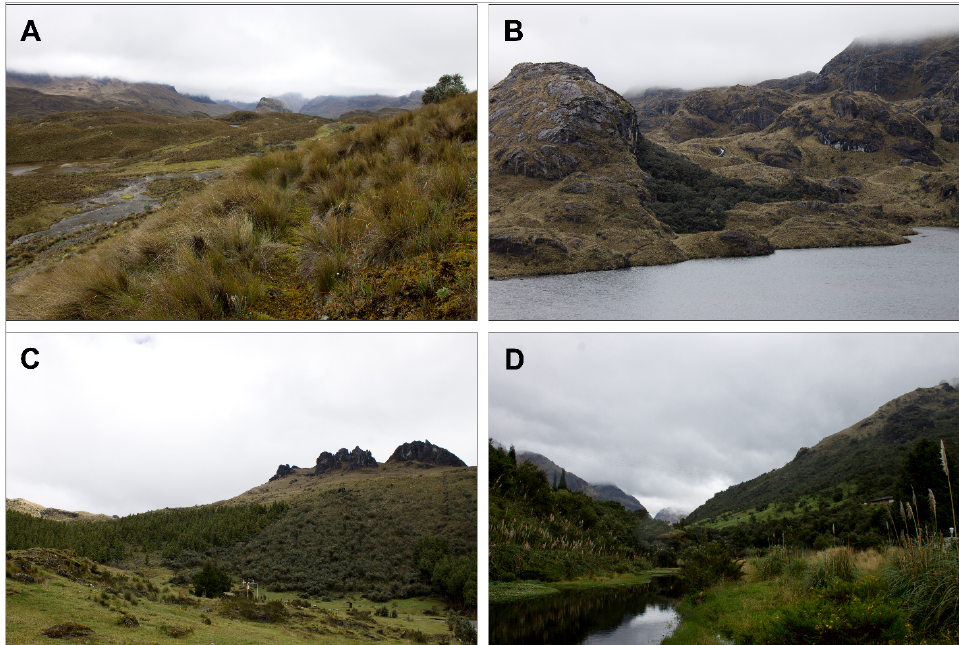
Figure 2. Views of the Quinoas catchment: ( A ) tussock grass and wetlands, upper valley; ( B ) Polylepis forests/water body, upper valley; ( C ) Pinus and evergreen native forest, mid valley; and ( D ) evergreen vegetation, low valley (photos by Andrés Abril, October 2015).